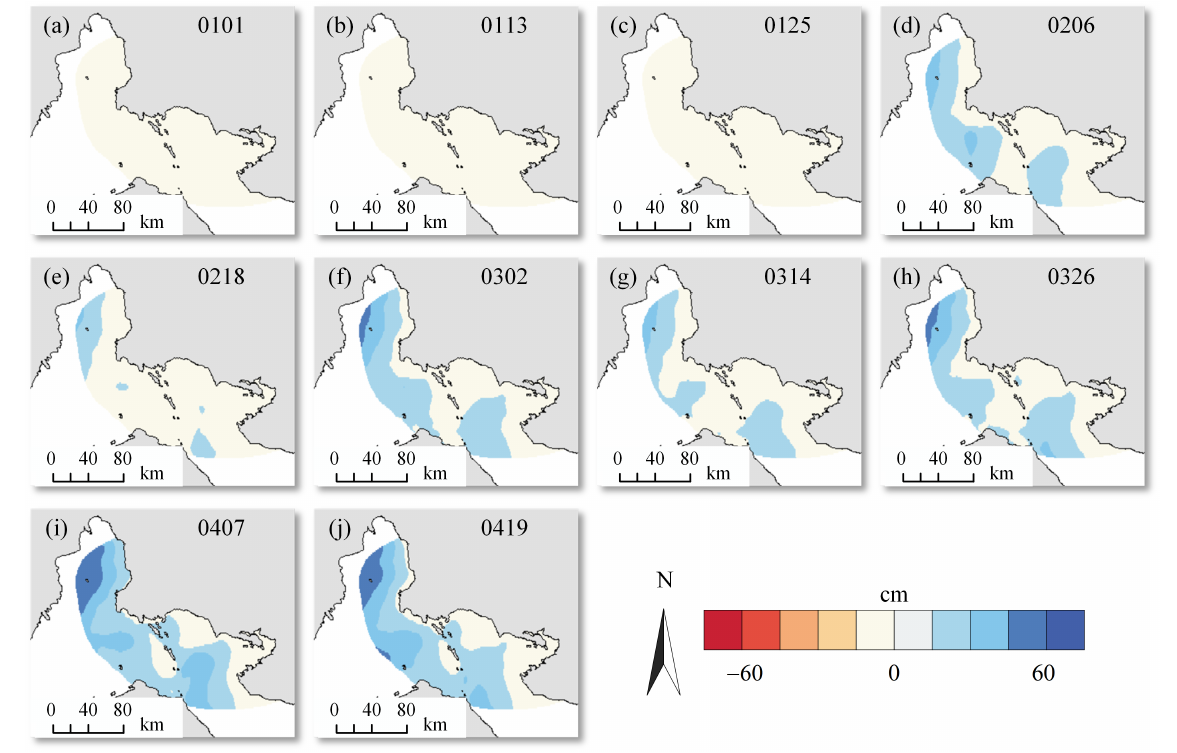
Figure A9. Time-series LOS deformation retrieved from the 2021 descending images: the top-right number of subfigures ( a – j ) represents the corresponding SAR images acquisition